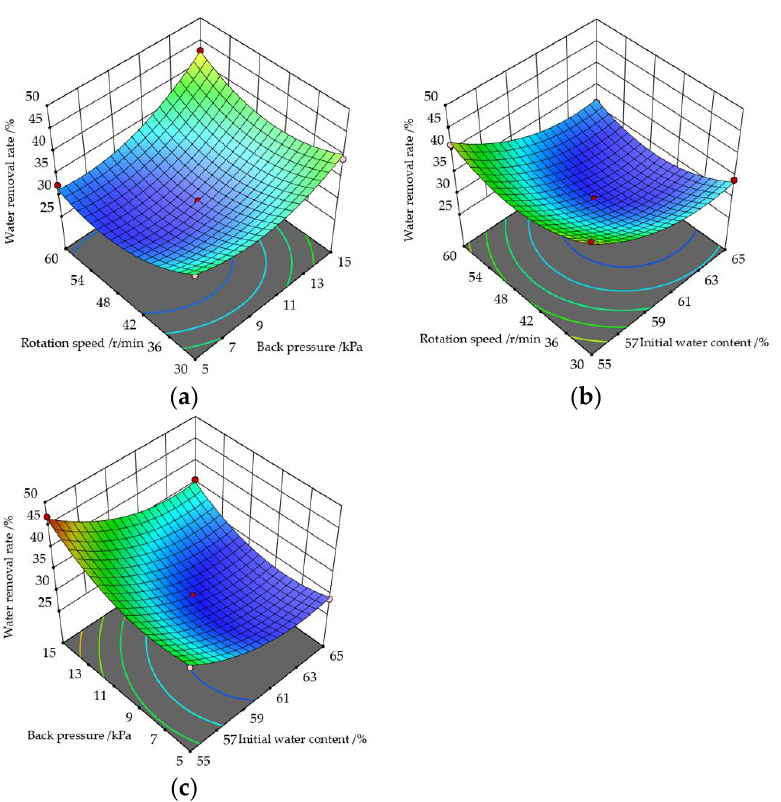
Figure 10. Relationship between water removal rate and interaction factors. ( a ) Interaction between rotation speed and back pressure. ( b ) Interaction between rotation speed and initial water content. ( c ) Interaction between back pressure and initial water content.